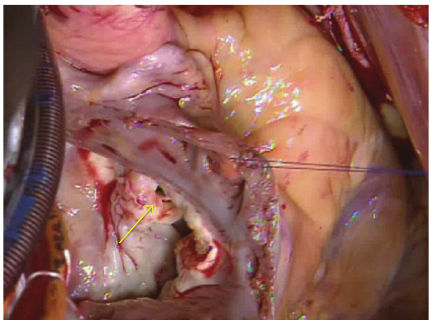
Figure 3: Perimembranous inlet-type VSD and membranous aneurysm ( ↑ ). The right-upper edge of the membranous aneurysm was tightly adhered and formed a mass with part of the tricuspid septal leaflet. The diameter of the VSD orifice was 8 mm while the original VSD size was speculated to be at least 15 ×